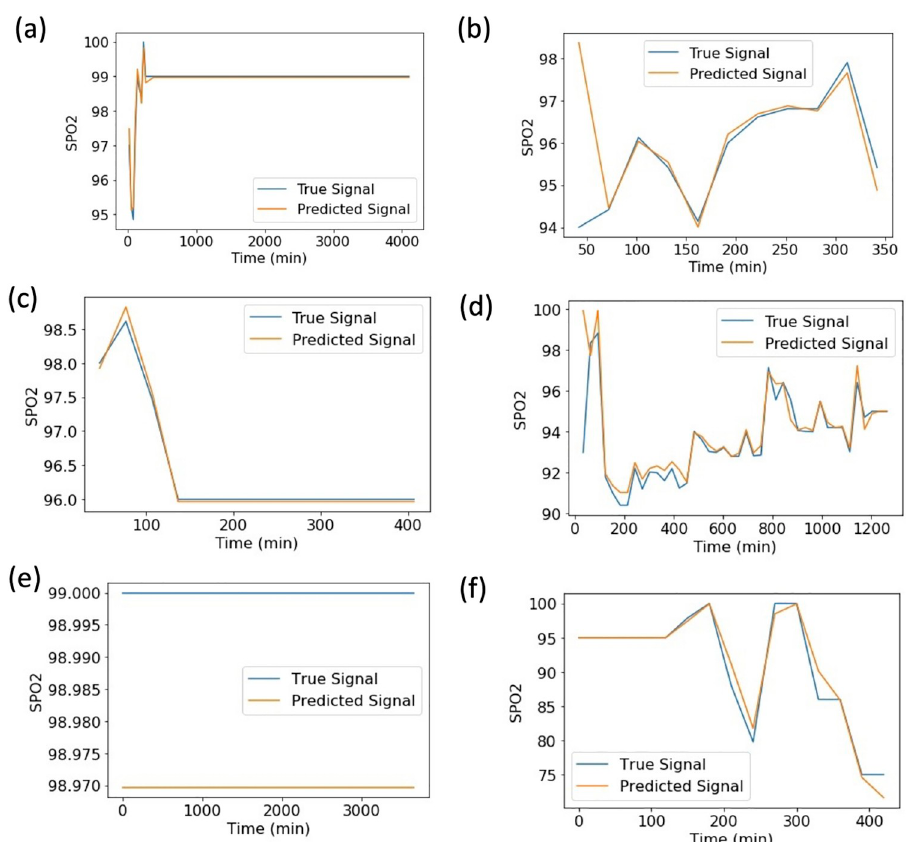
Fig 5. Examples of the best and worst fits by MSE for SWIFT-30 model tested on (a) eICU Ventilated patients–best fit, (b) eICU Ventilated patients–worst fit, (c) eICU Non-Ventilated patients–best fit, (d) eICU Non-Ventilated patients– worst fit, (e) JH-CROWN patients–best fit, (f) JH-CROWN patients–worst